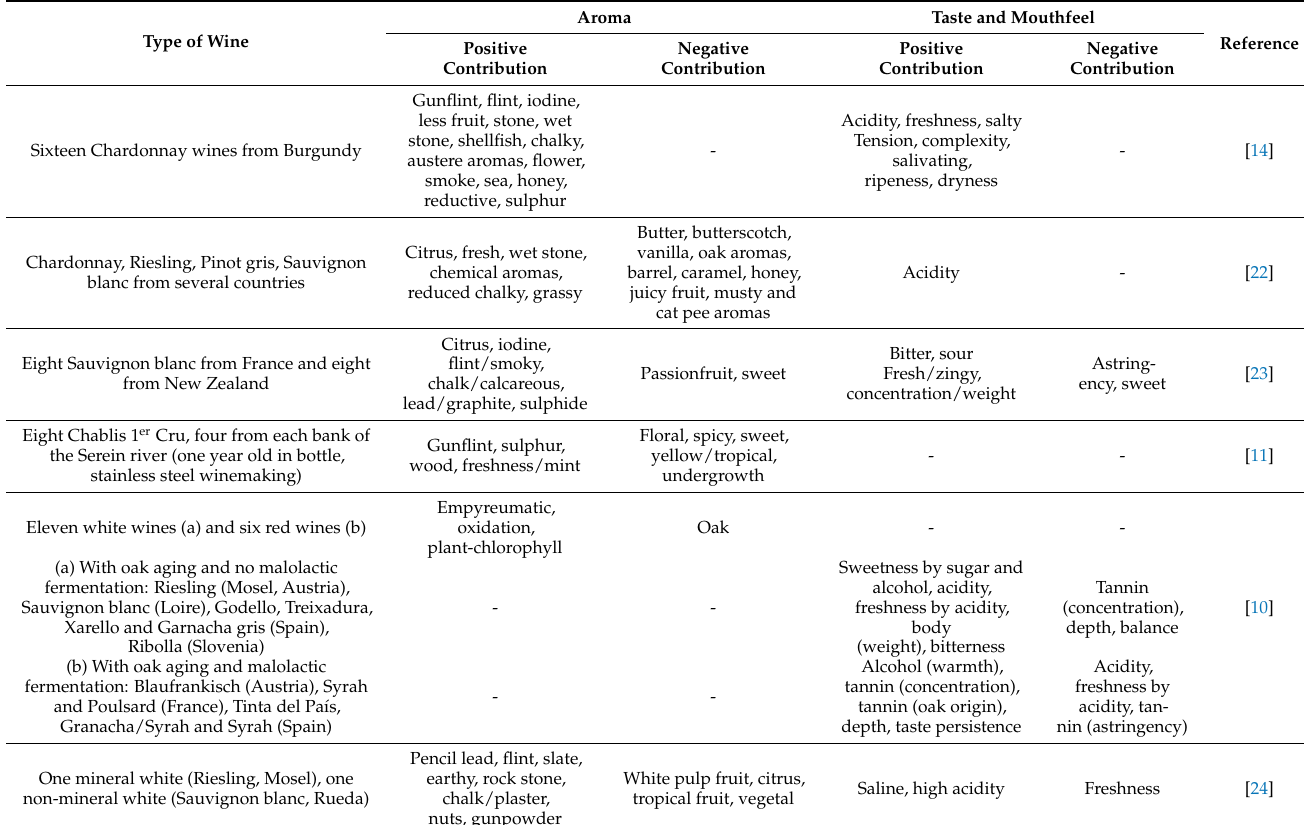
Table 1. Definition of the minerality sensory conceptual space based on wine